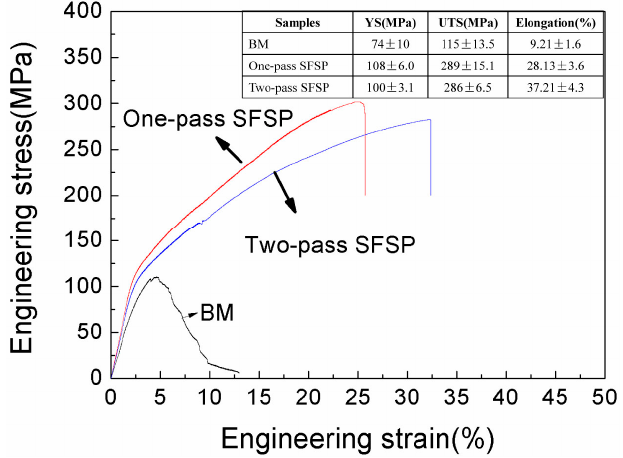
Figure 8. Tensile stress–strain curves for BM and the SFSP AZ61 specimens. YS, UTS and elongation to fracture of BM, one-pass, and two-pass SFSP specimens are listed in the table.